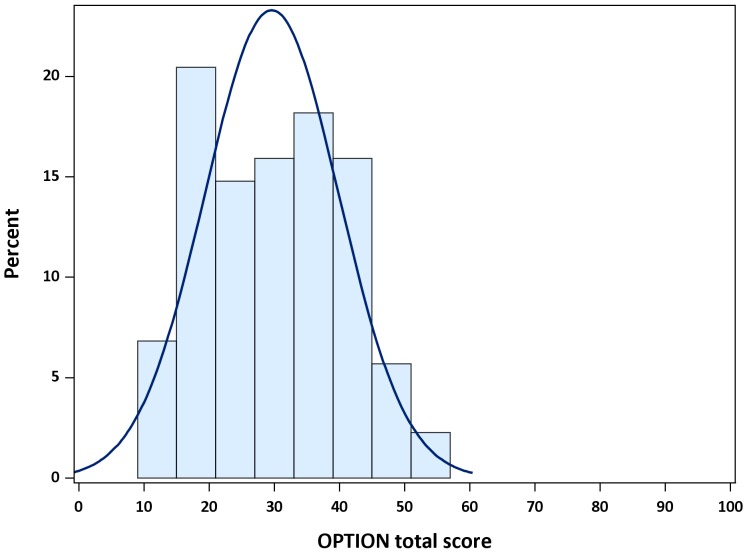
Frequency distribution of Observing Patient Involvement in Shared Decision Making (OPTION) total score (88 consultations).The line is the normal density plot. The x axis shows the full range of possible scores (0–100).